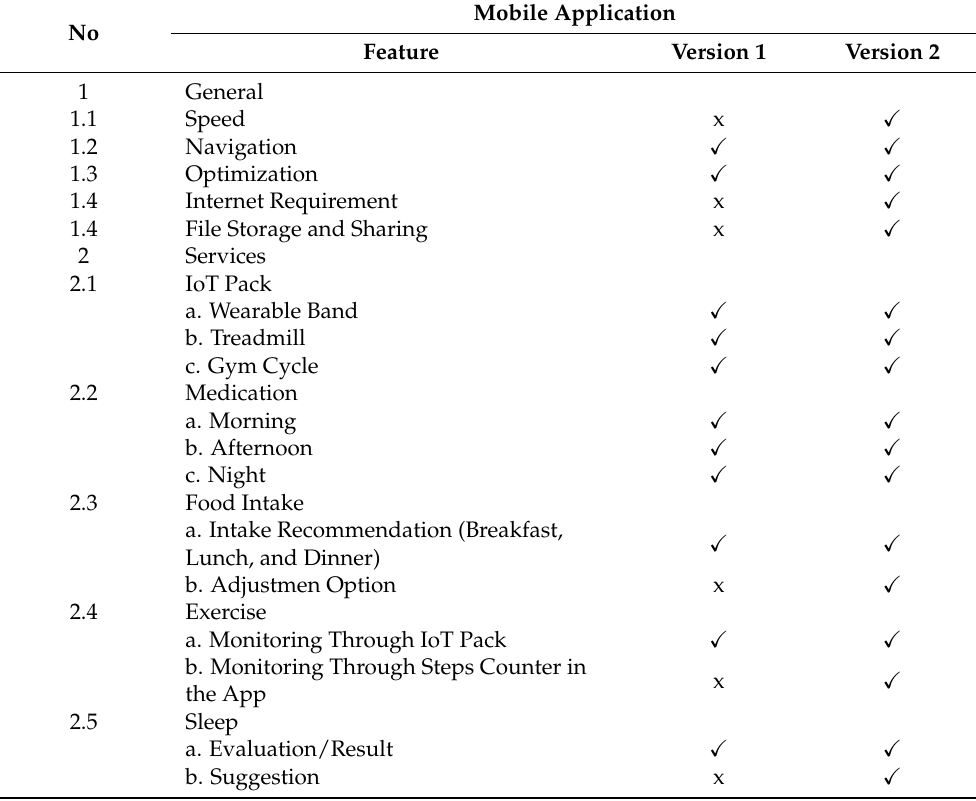
Table 13. Mobile Application’s Feature